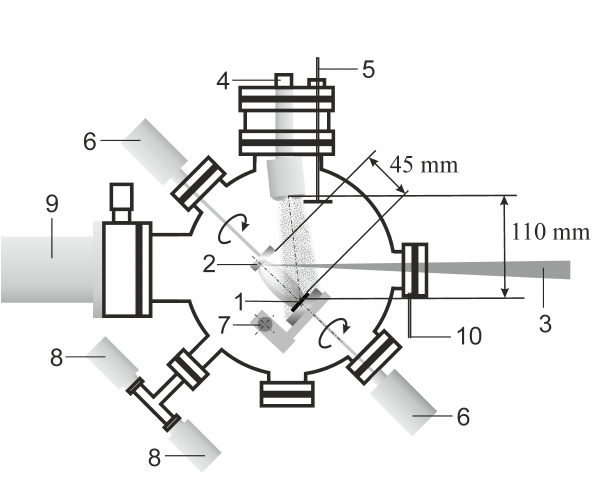
Figure 2. The scheme of hybrid deposition system: 1 - Substrate, 2 - Carbon target, 3 - Laser beam, 4 - Magnetron with Cr target, 5 - Magnetron stopper, 6 - Rotation, 7 - RF, 8 - Vacuum gauge, 9 - TBM, 10 - Gas flow (Ar).